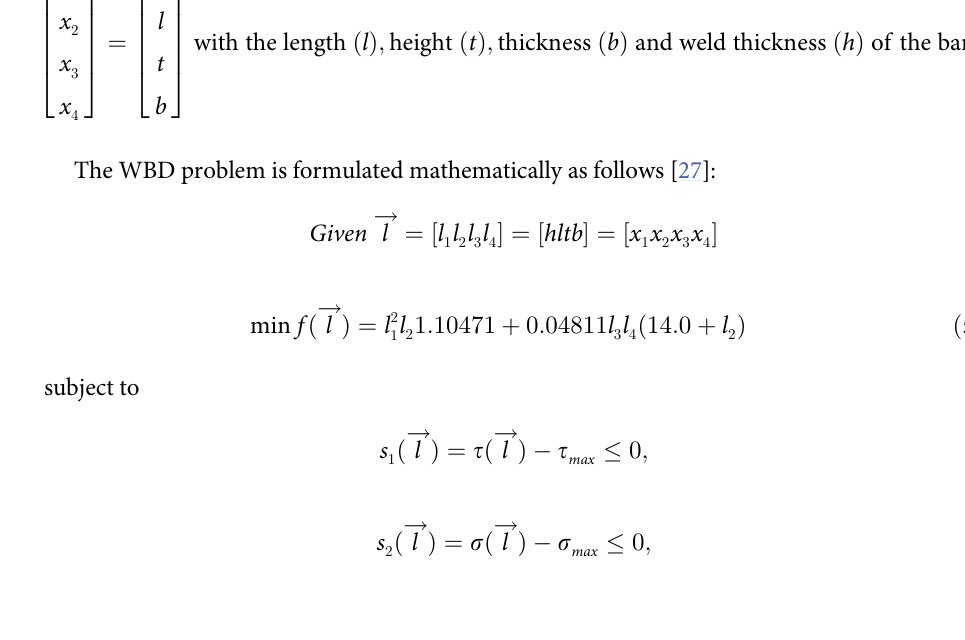
with the length ð l Þ ; height ð t Þ ; thickness ð b Þ and weld thickness ð h Þ of the bar :: 7 5